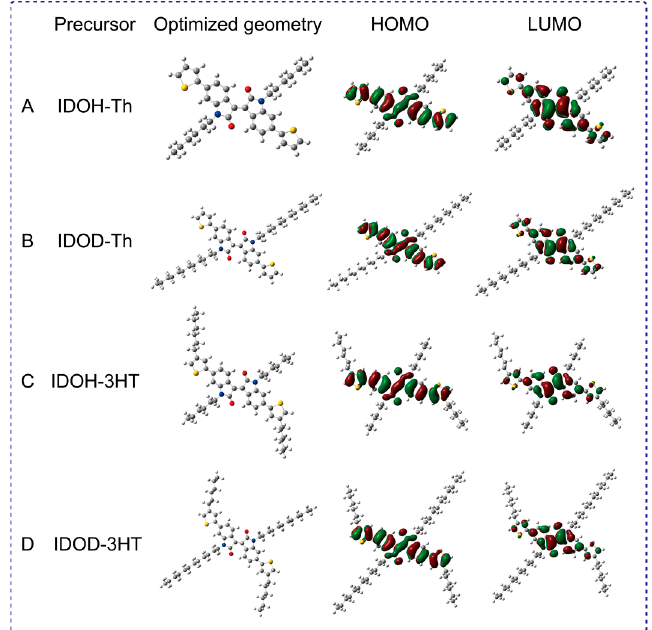
Figure 3. Optimized geometries and HOMO–LUMO orbital distribution of IDOH–Th ( A ), IDOD–Th ( B ) IDOH–3HT ( C ), and IDOD–3HT ( D